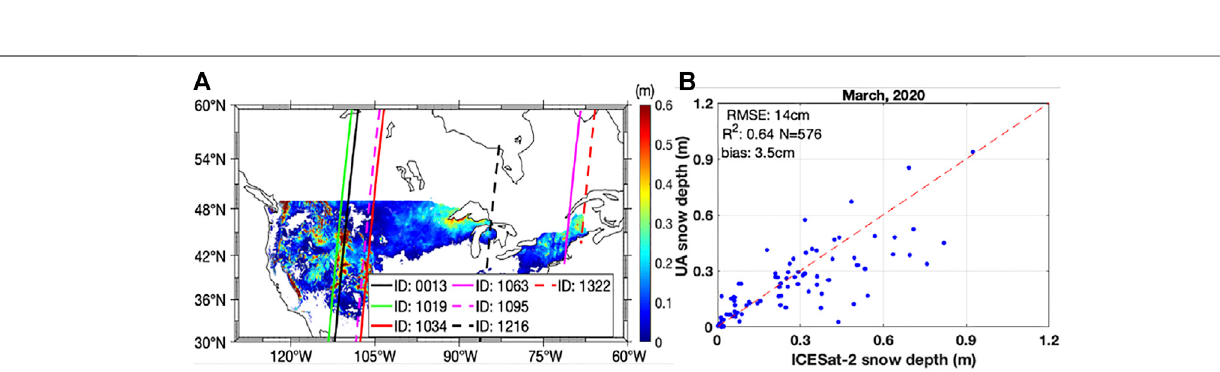
FIGURE 6 | The snow depth comparisons on 27 March 2020 from three different sources: ICESat-2 (blue), UA daily 4 km gridded snow product (red), and CMC daily24 kmgridded snowproduct (green). TheICESat-2 groundtrack isshown assolidblack linein Figure7A .Note thatthelocationsof x -axis aredifferentinthe three panels for ICESat-2 three strong beams, which are separated by ~3.3 km in the across-track direction.